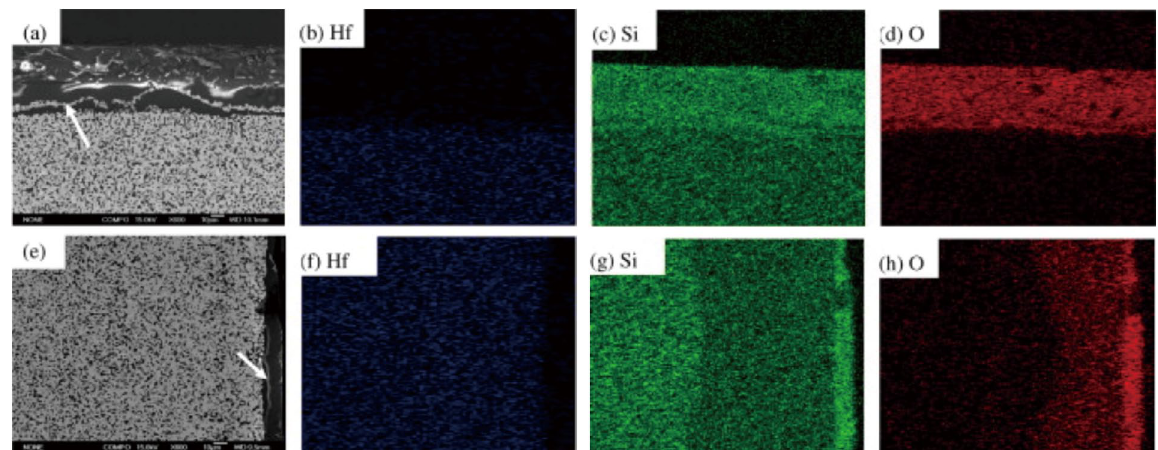
Fig. 35 Cross-section images and EDS elemental maps of different surfaces for HS20 after oxidation at 1600 ℃ for 10 h in stagnant air: (a–d) the surface perpendicular to the magnetic field direction; (e–h) the surface parallel to the magnetic field direction. Reproduced with permission from Ref. [253], © Acta Materialia Inc.